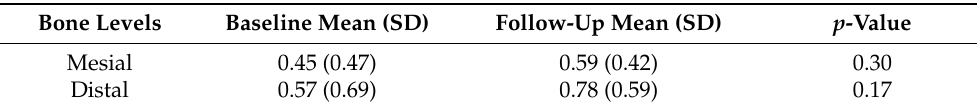
Table 2. Mean bone